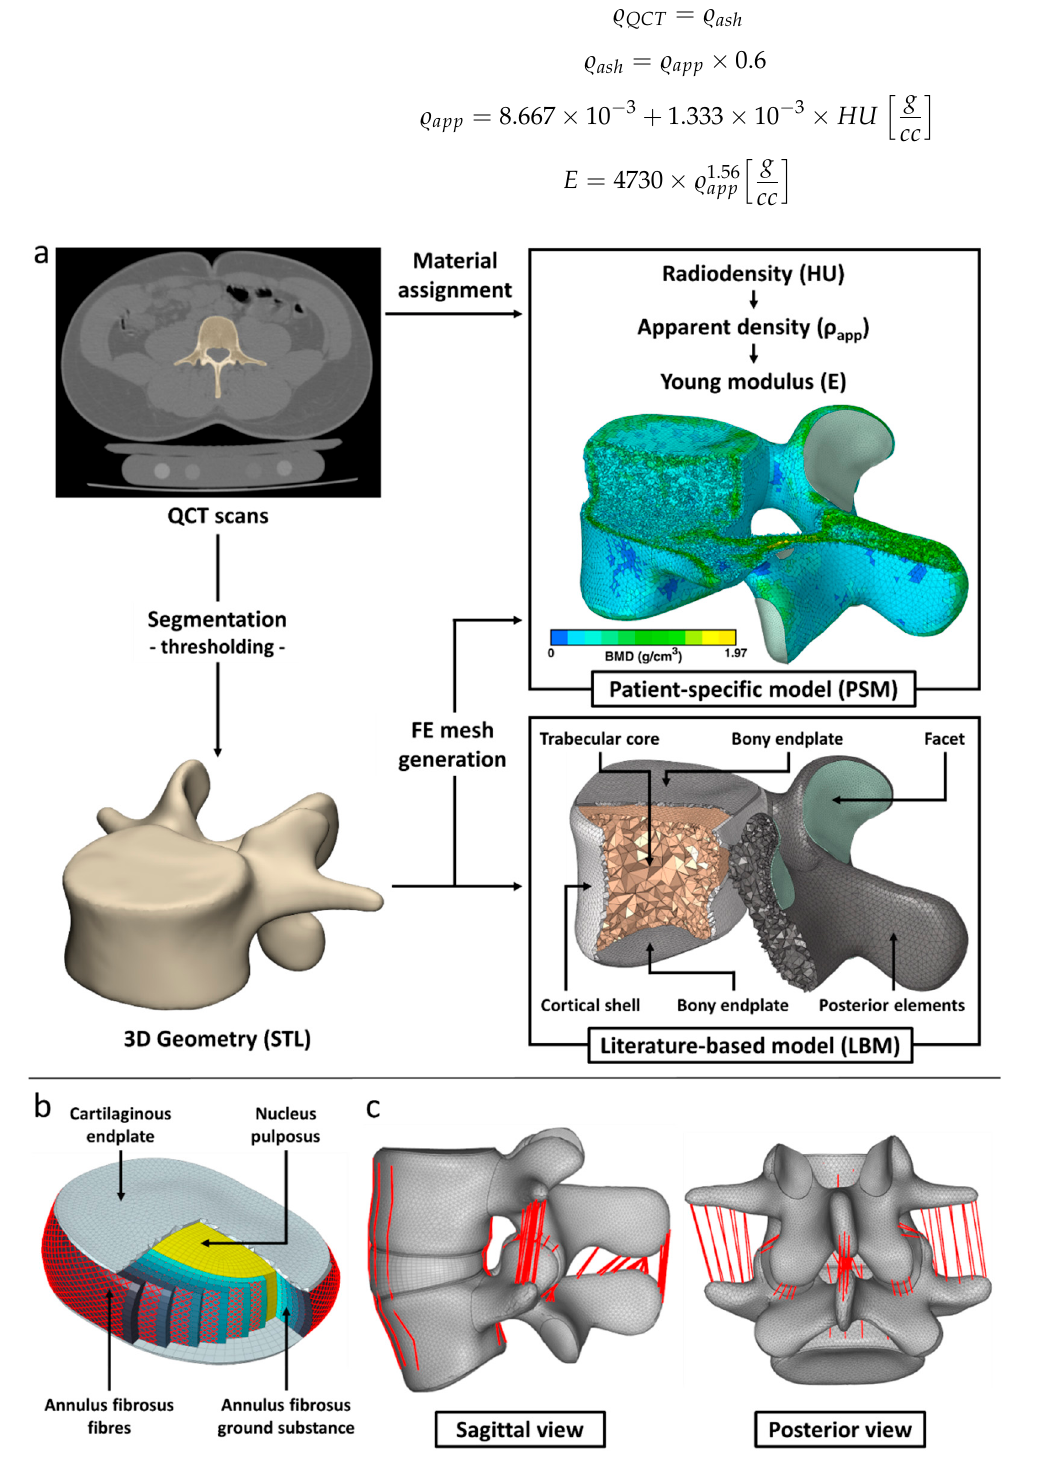
Figure 1. Workflow of the FE model development. ( a ) The geometry of the LBM and the PSM was defined by segmentation based on QCT scans. The smoothed and remeshed surface mesh was used for the volume meshing. For the LBM, the applied material properties were taken from the literature, while for the PSM, the bone material was assigned according to the HUs, using multiple sets of equations. ( b ) The FE model of the intervertebral disc includes the cartilaginous endplate, the nucleus pulposus, the annulus fibrosus ground substance, and the collagen fibres. ( c ) Ligaments are illustrated on the L4–L5 FE model in sagittal and posterior views.